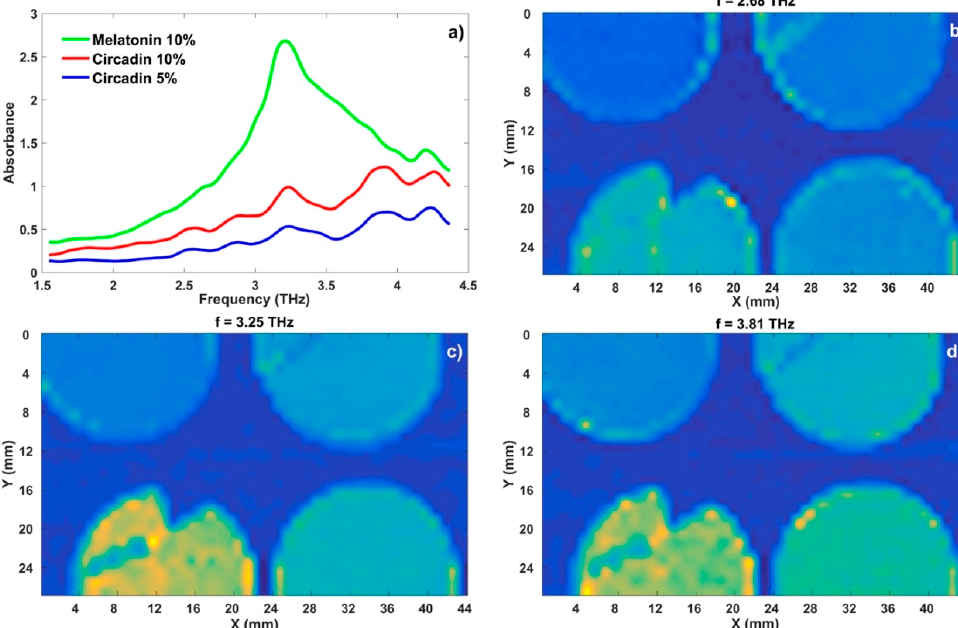
Figure 5. ( a ) THz spectra of melatonin and Circadin with two different concentrations. ( b – d ) THz spectroscopic images at the most representative discrete frequencies. On each THz image the samples/pellets are arranged as follows: Top left—PE, top right—Circadin 5 wt%, bottom left—melatonin 10 wt%, bottom right—Circadin 10 wt%.